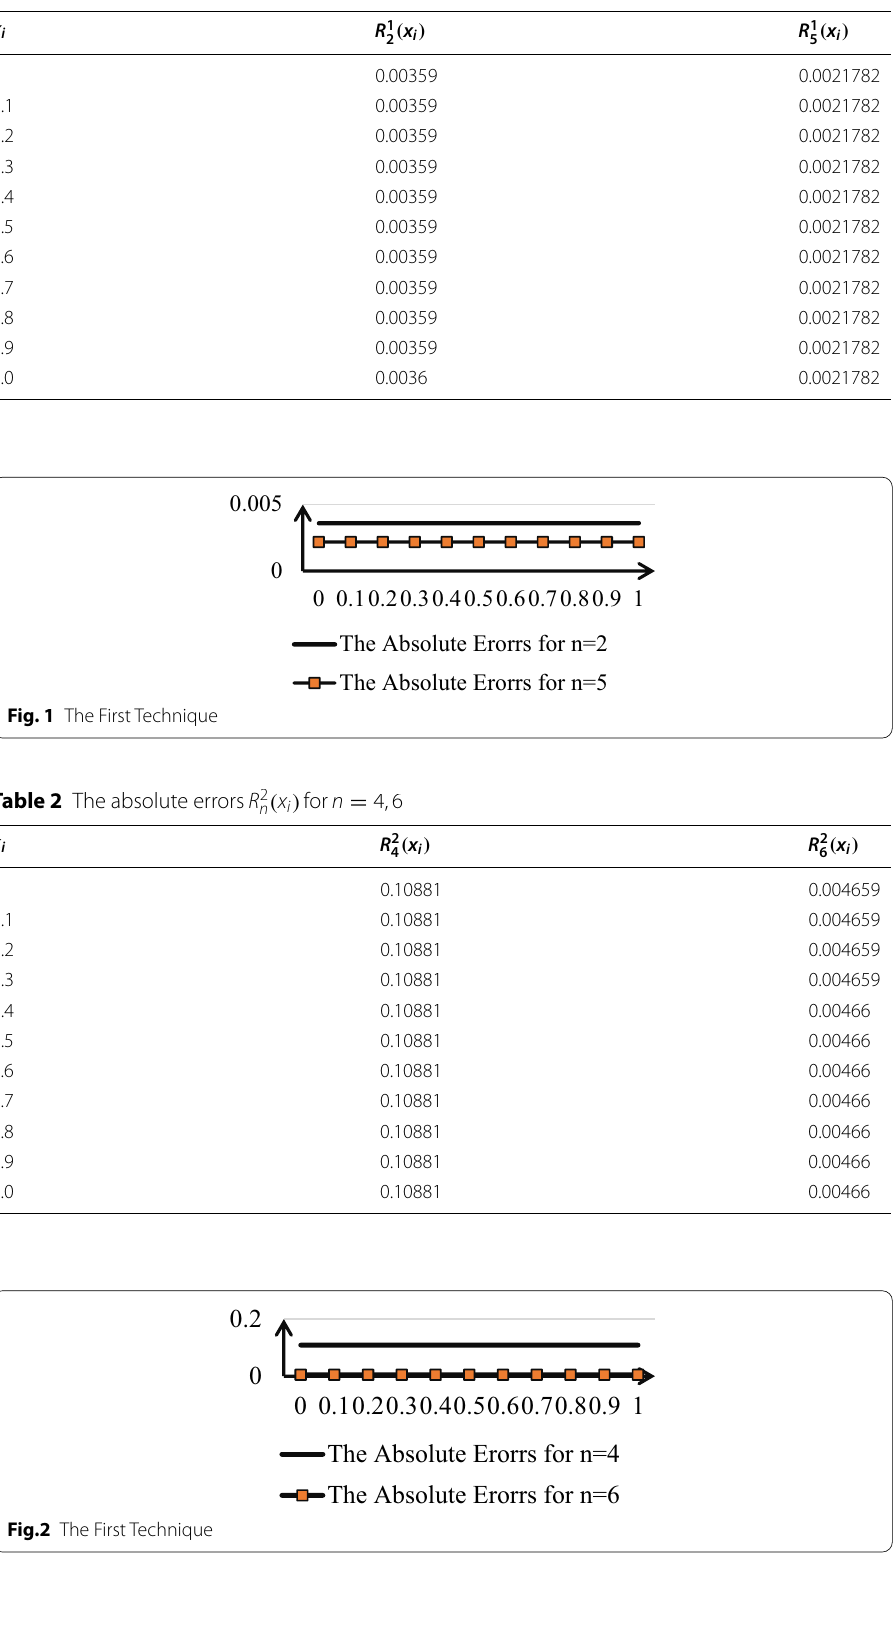
Table 1 The absolute errors R 1 n ( x i ) for n = 2,